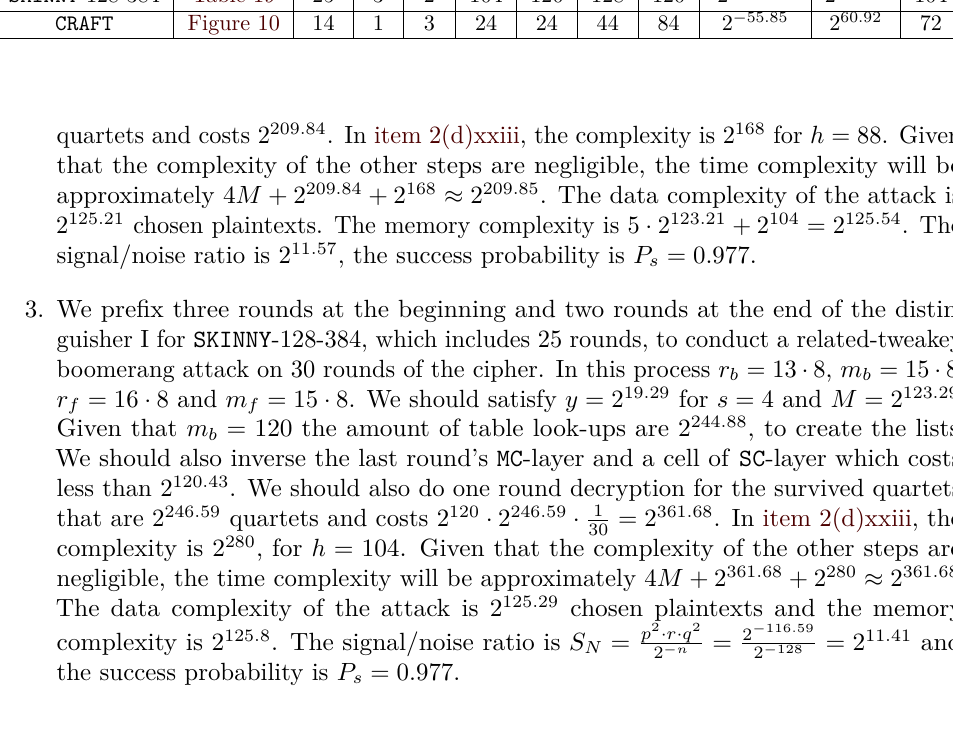
and n respectively denote the used distinguisher, the b f